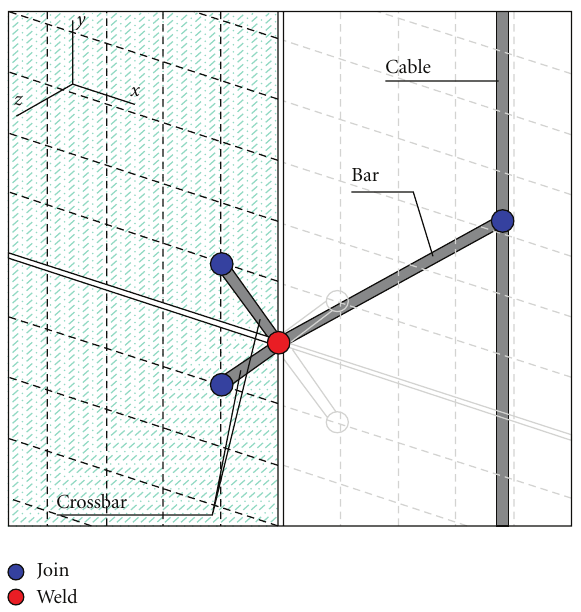
Figure 3: Detail of half-spider connector (4-hole, ABAQUS).